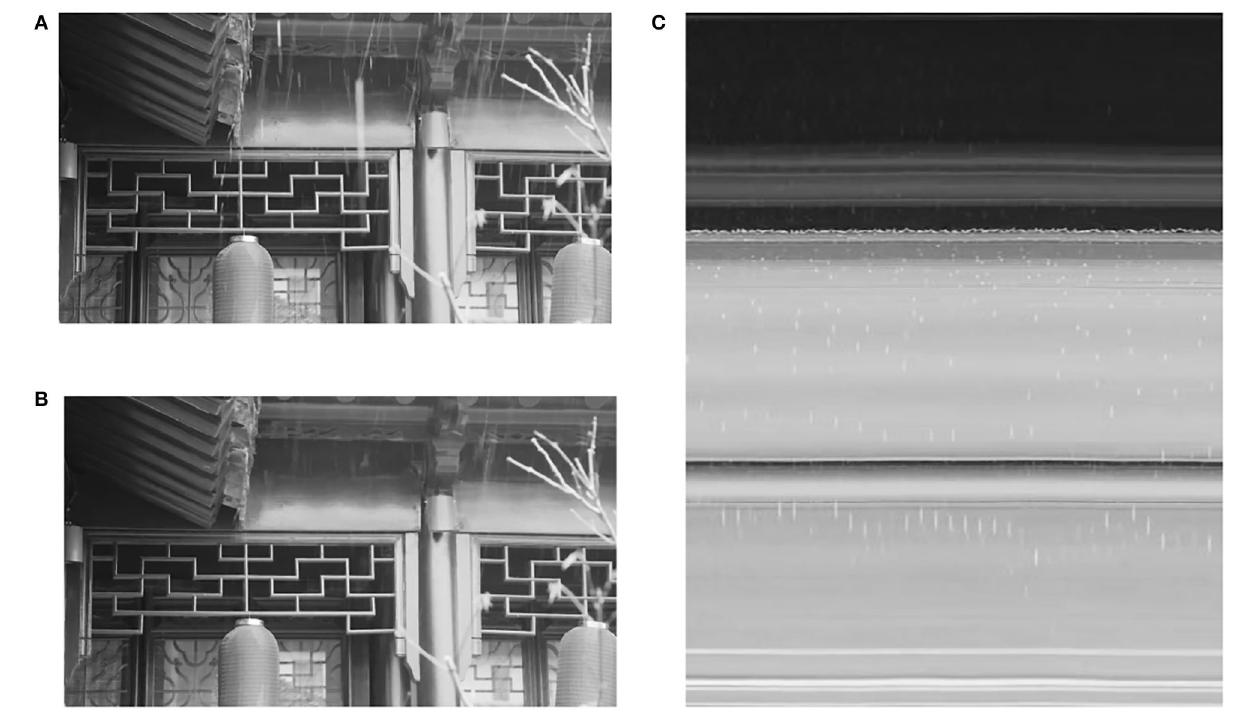
FIGURE 7 | (A) One image selected from a normal rainy video. (B) The corresponding output image from our approach. (C) One image in the W-T space sliced at a height of